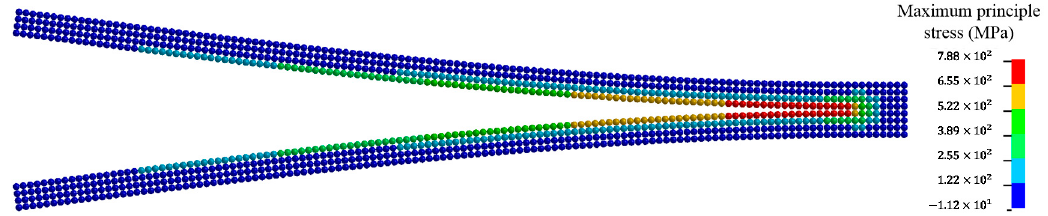
Figure 10. Deformed configuration of the DCB model at t (cid:3404) 35 ms.